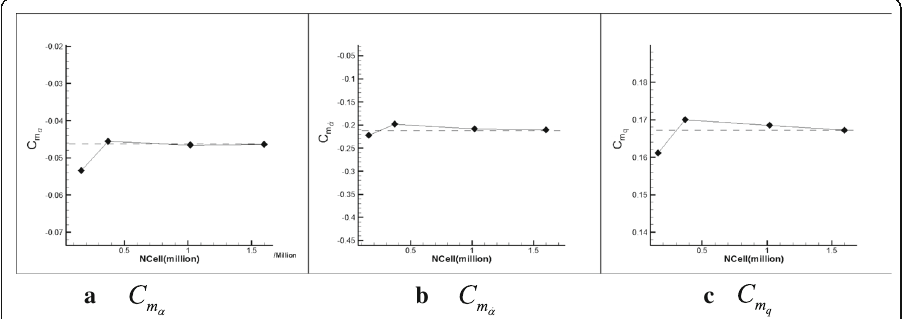
Fig. 6 The time-average values of C m